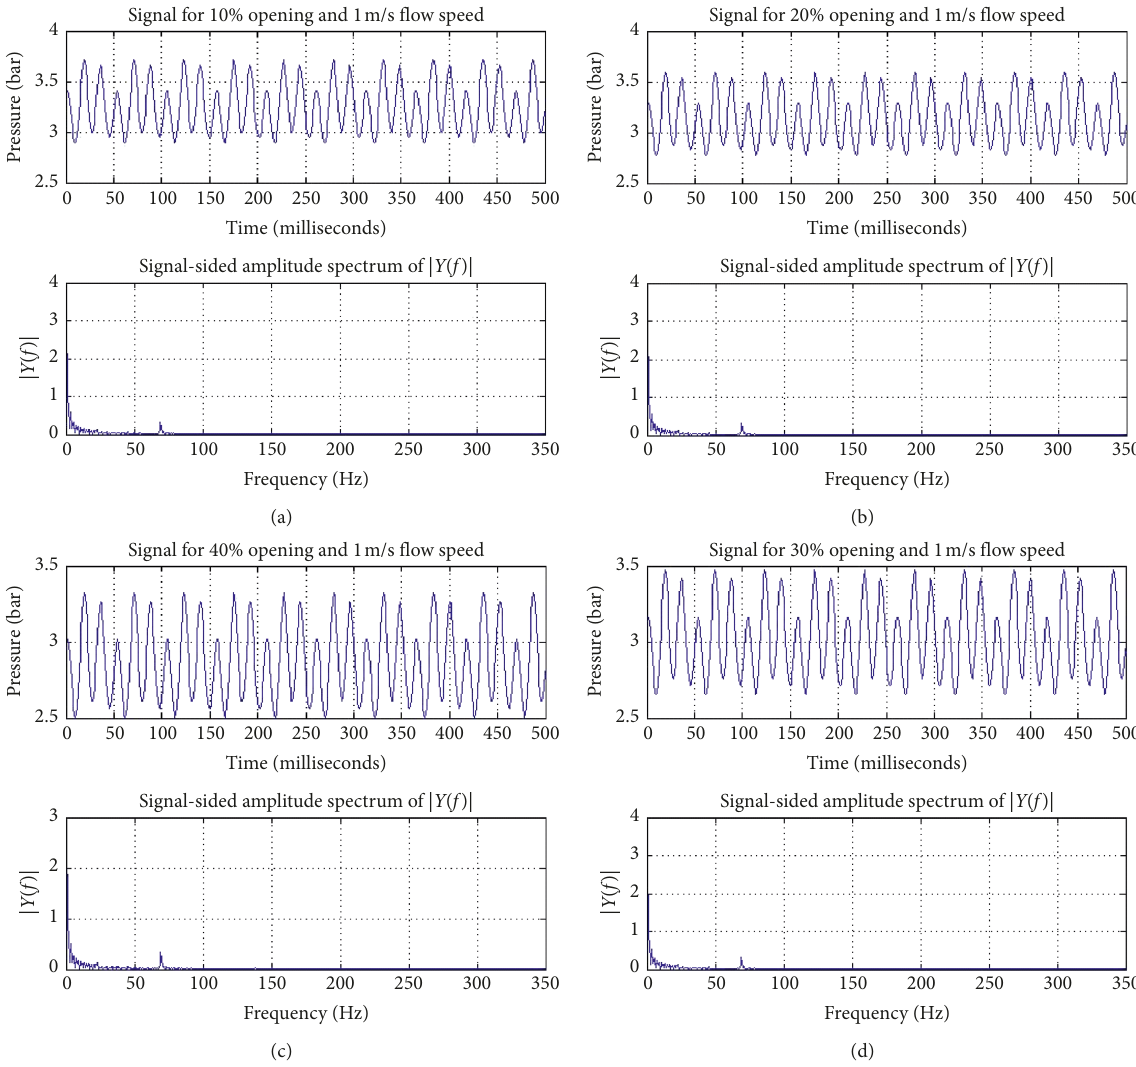
Figure 9: Pressure drop for flat face plug with flow velocity 1m/s and different valve opening. (a) 10% valve opening; (b) 20% valve opening; (c) 30% valve opening; (d) 40% valve